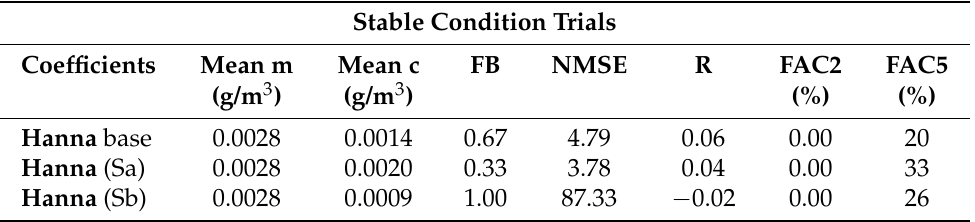
Table 1. Statistical analysis for the mean concentrations in the stable